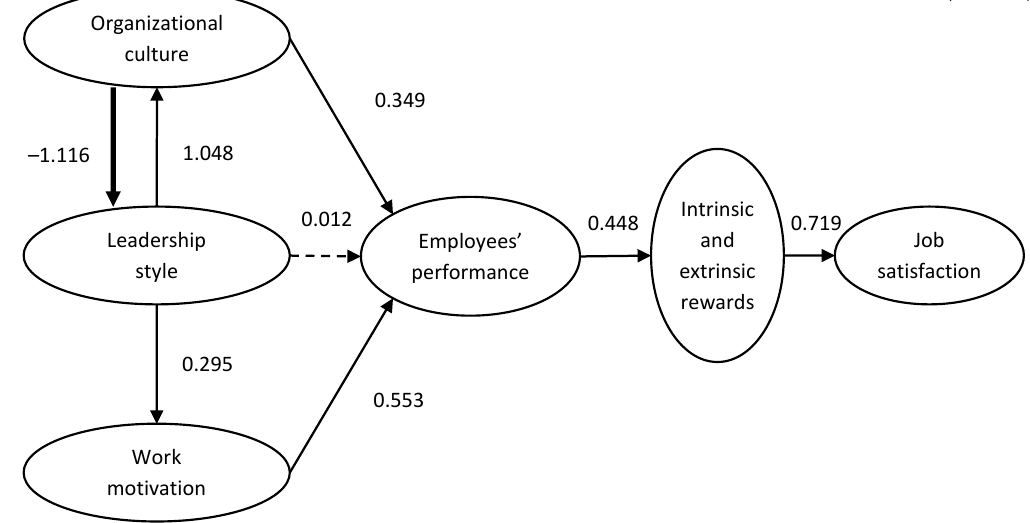
Source: Result processed